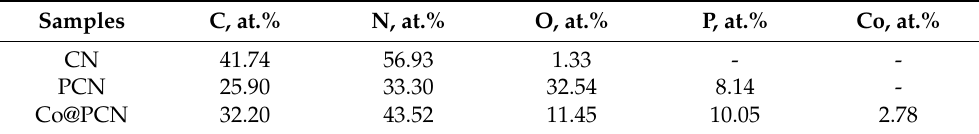
Figure 3. ( a ) XPS survey spectrum and high-resolution XPS spectra of ( b ) C 1s, ( c ) N 1s, ( d ) O 1s, ( e ) P 2p, and ( f ) Co 2p core levels in flame-retardant particles. Table 1. The C, N, O, P, and Co atomic percentage of CN, PCN, and Co/PCN.